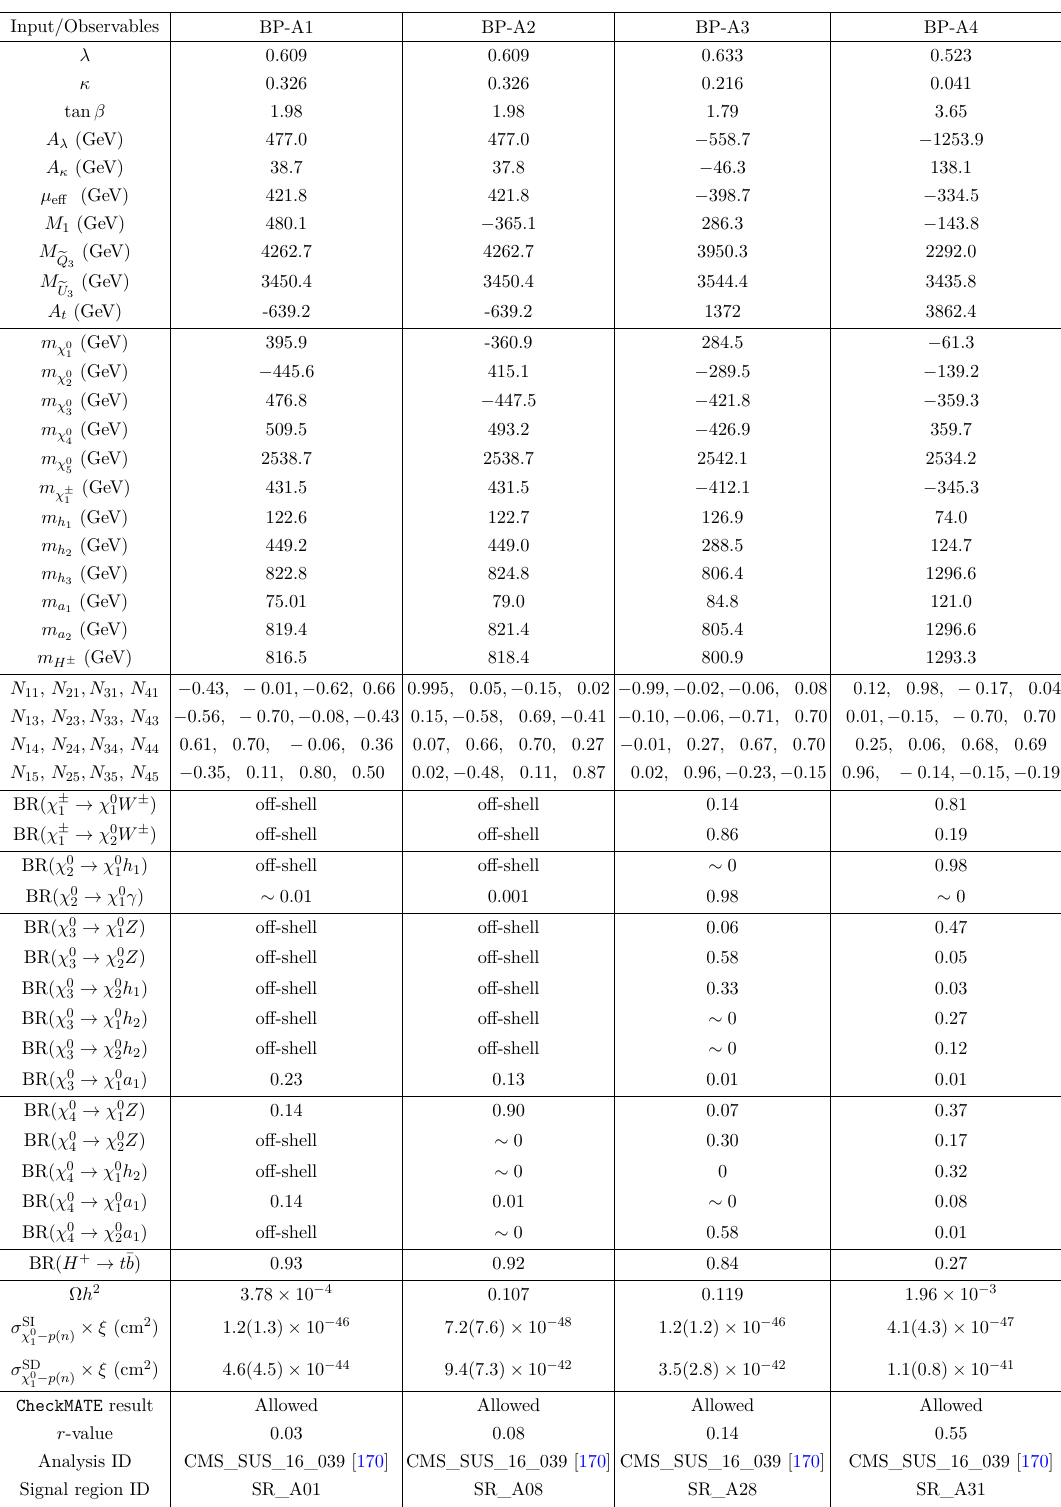
Table 4. Same as in table 3 except for showing benchmark scenarios (with successful nucleation) allowed by all relevant theoretical and experimental constraints including the recent ones from the LHC electroweakino searches. The details of the EWPT are indicated separately in tables 5 and